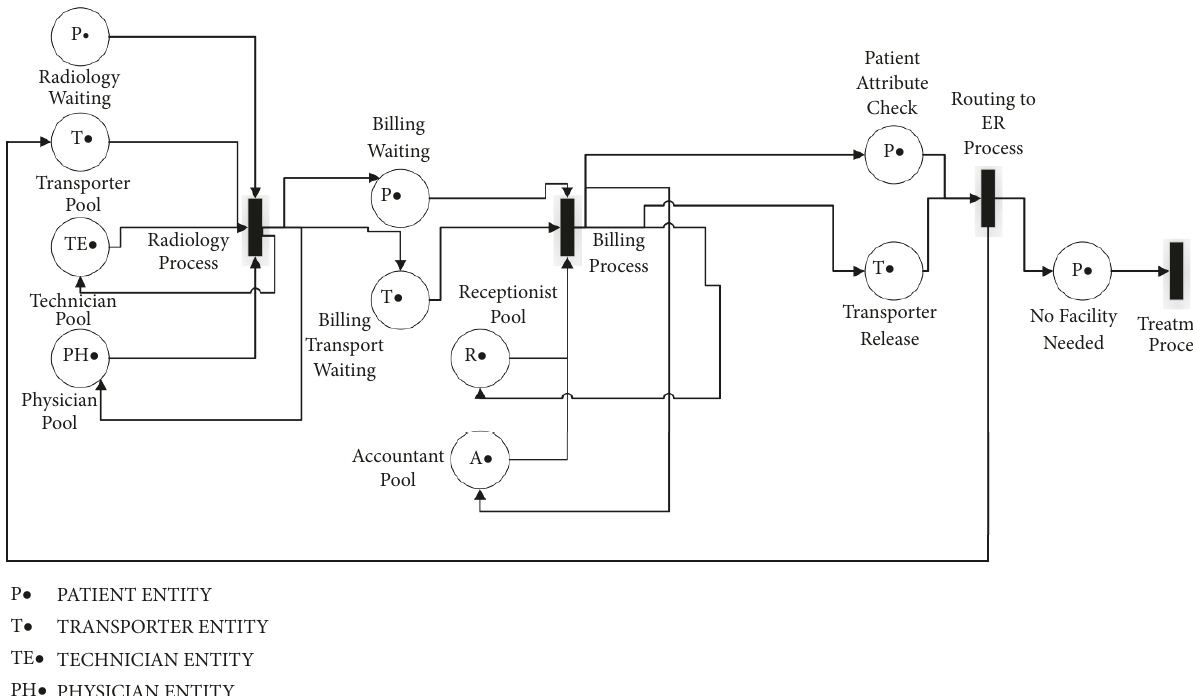
Figure 3: Petri net radiology/billing.